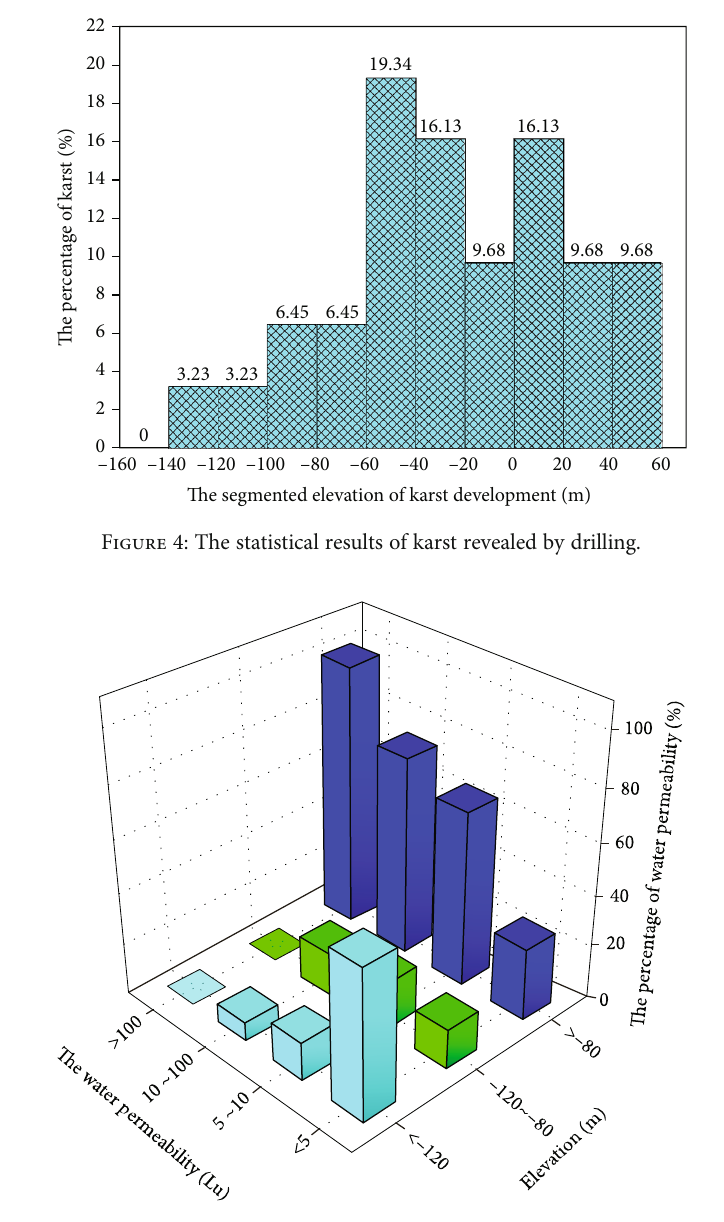
Figure 5: The statistical results of the subsection and subelevation of the water-pressure